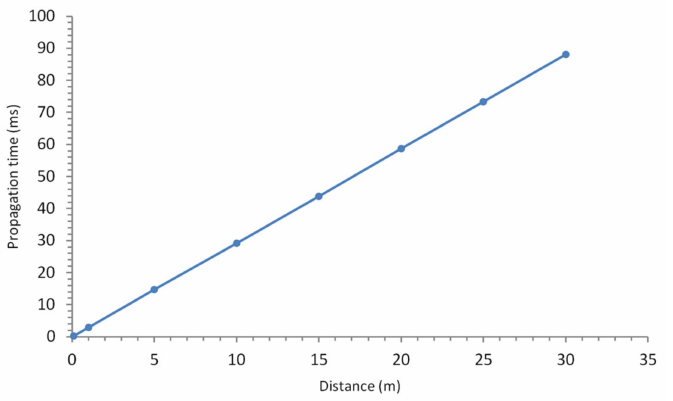
Figure 11. Dependence of propagation time of ultrasonic waves on the distance